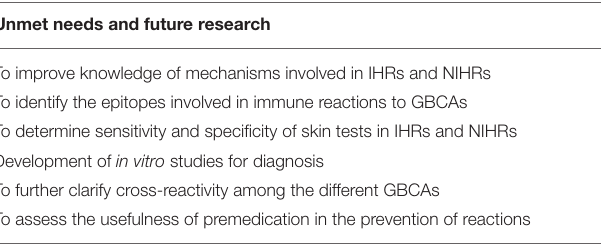
TABLE 4 | Unmet needs and future